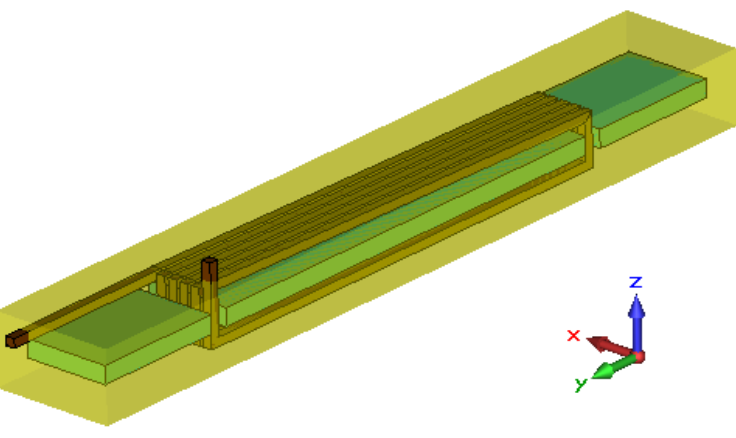
Figure 16. Simplified Micro-PLCD sensor model.